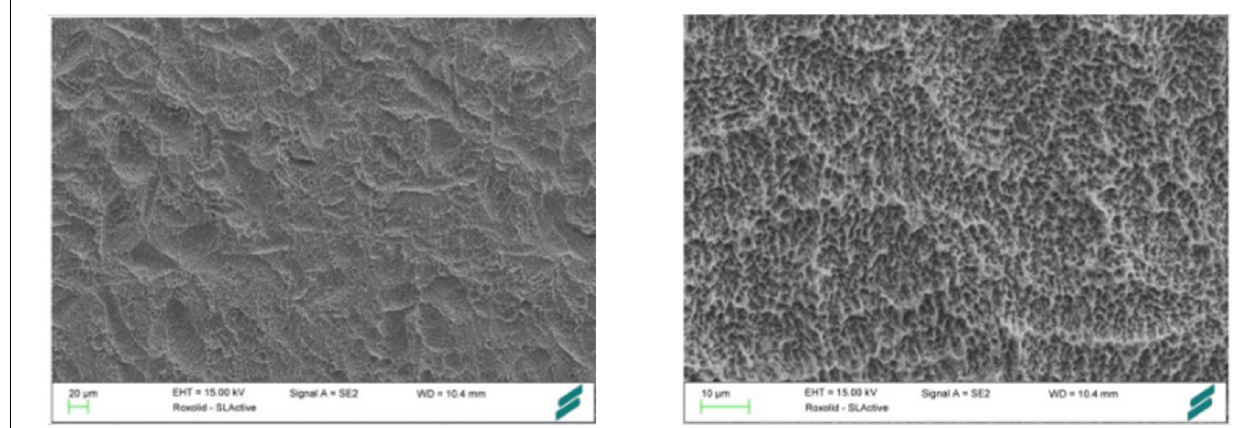
FIGURE 7 | Scanning electron micrographs of a SLActive dental implant